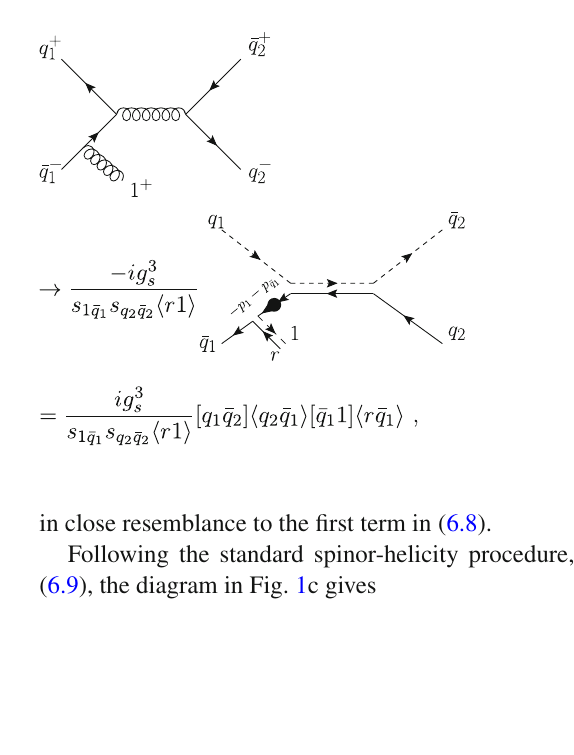
δ q 1 ¯ q q 2 ¯ q 1